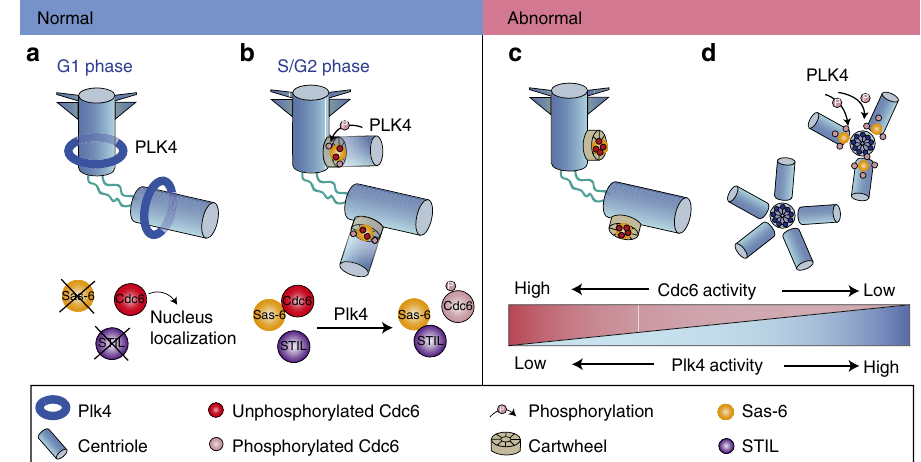
Figure 8 | Model elucidating that Cdc6 and Plk4 antagonistically regulate centrosome duplication. During G1 phase, Plk4 localizes in a ring-like manner surrounding the parental centrioles, while the procentriole formation core protein Sas-6 and STIL are degraded. Cdc6 localizes in the nucleus and is absent at the centrosomes during G1 phase. Centrosome duplication cannot initiate at this time ( a ). When the cells progress into S phase, Cdc6 is recruited to the cartwheel of the centrosome by cyclin A to inhibit untimely centrosome duplication. To trigger centrosome duplication during S phase, Plk4 gradually phosphorylates Cdc6 and attenuates the interaction of Cdc6 with Sas-6, facilitating Sas-6 to form a stable complex with STIL, which then triggers centrosome duplication ( b ). Unphosphorylated Cdc6 exerts a stronger inhibitory role on Sas-6 and attenuates the interaction between Sas-6 and STIL, and thus restrains the procentriole growth ( c ). By contrast, constant phosphorylation of Cdc6 by Plk4 abolishes its inhibitory activity on Sas-6 to allow Sas-6 forming a stable complex with STIL to initiate the centrosome over-duplication ( d ). Therefore, the balance of Cdc6 and Plk4 activities is crucial for the normal centrosome duplication. In summary, we propose that Cdc6 is a novel negative regulator of centrosome duplication, controlling the timely and proper centrosome duplication during the cell